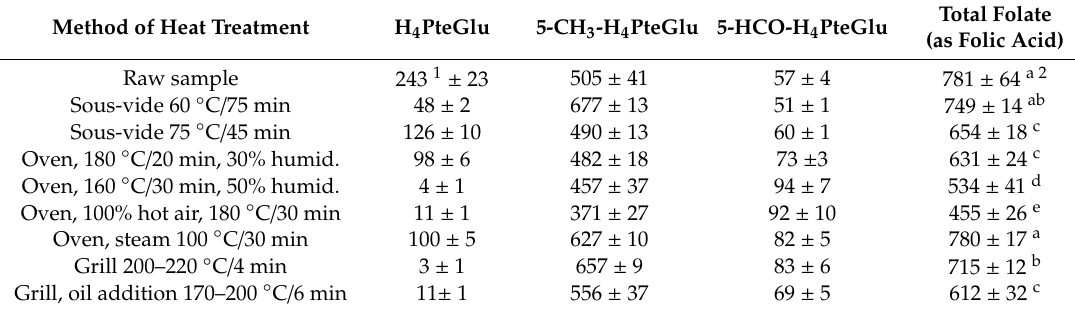
Table 2. Folate content in raw and processed chicken liver ( µ g / 100 g fresh weight